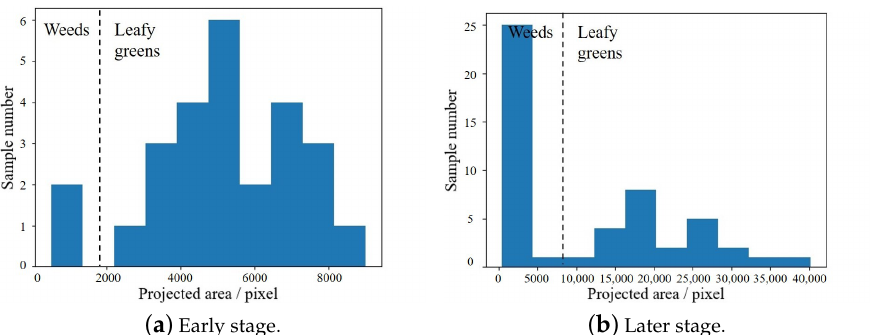
Figure 4. Histogram of predicted instance pixel area statistics. In the early stage, the number of weeds is small, as shown in Sub-figure ( a ). In the late stage, the number of weeds may be large, as shown in Sub-figure ( b